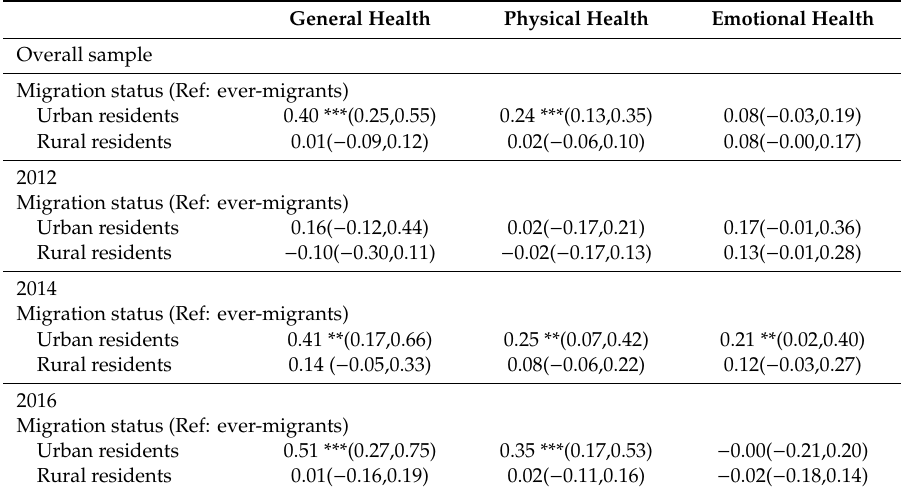
Table A1. Marginal e ff ects of migration status (comparing with ever-migrants).